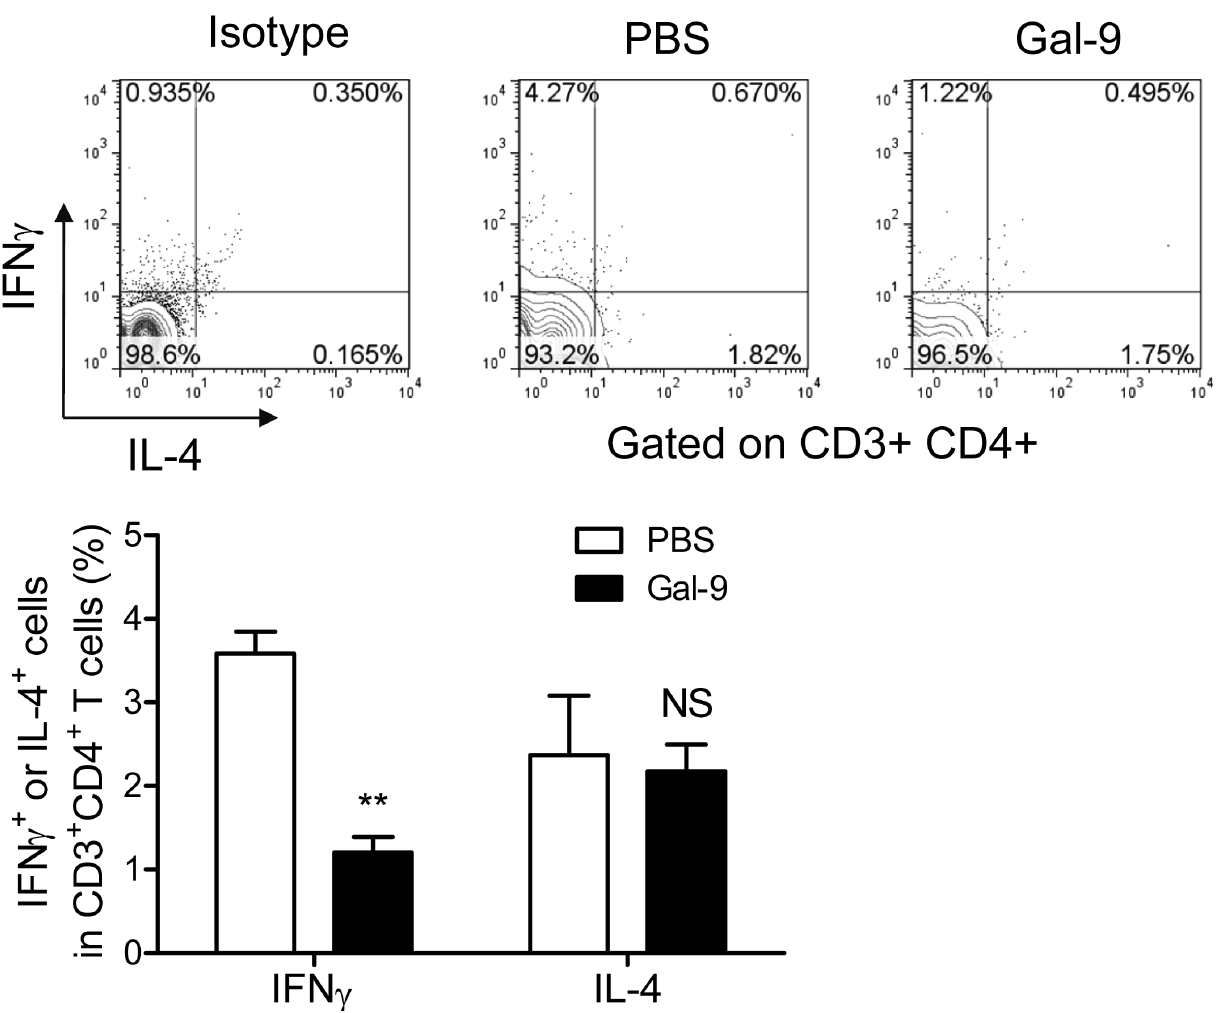
Figure 2. Effects of Gal-9 on splenic Th1 and Th2 subsets in MRL/lpr mice. Comparison of IFN c + Th1 and IL-4 + Th2 frequency between PBS- treated (n=4) and Gal-9-treated (n=4) mice (***, P , 0.001). Representative data of flow cytometric profiles are shown.